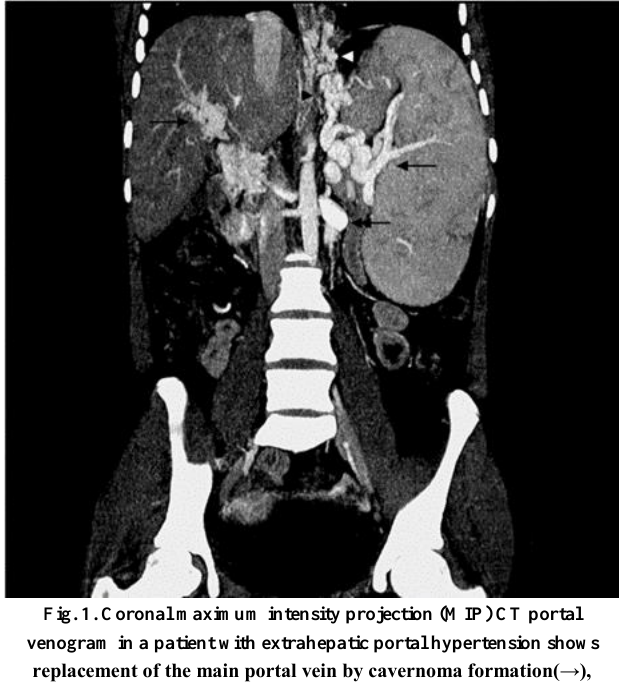
Fig. 1. Coronal maximum intensity projection (MIP) CT portal